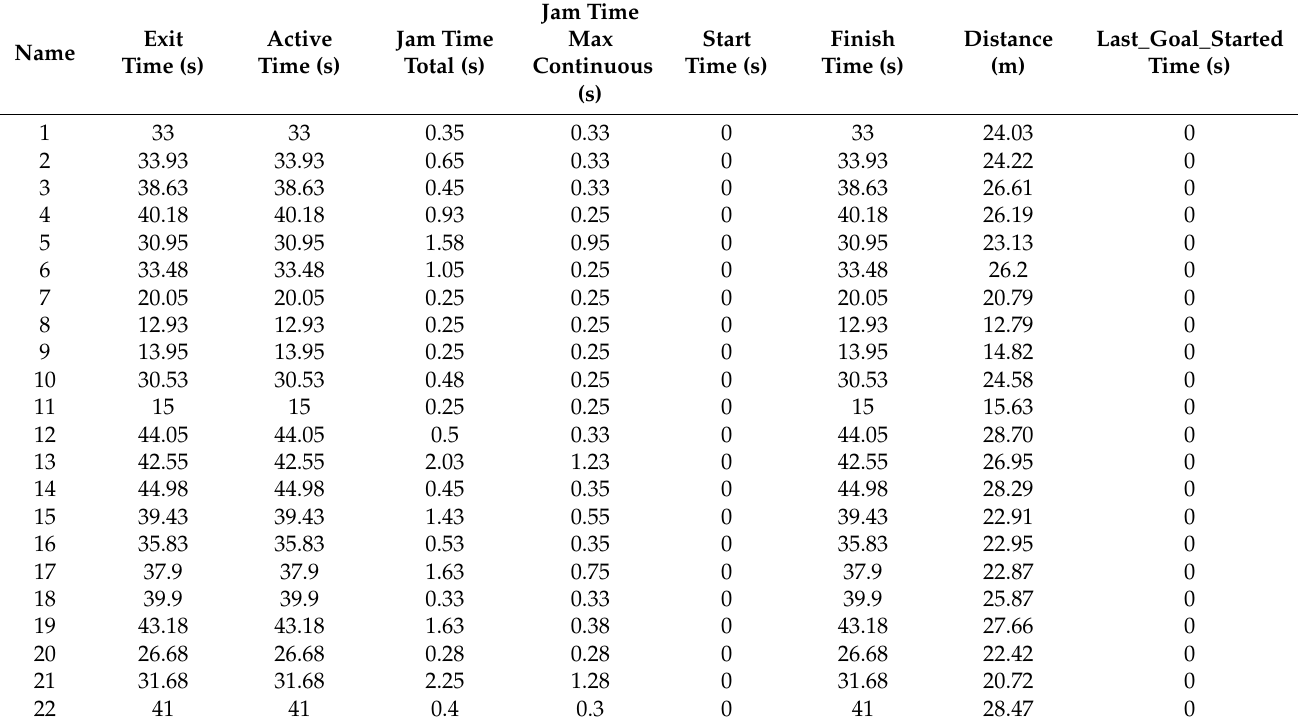
Table 3. Partial data recorded by Pathfinder.